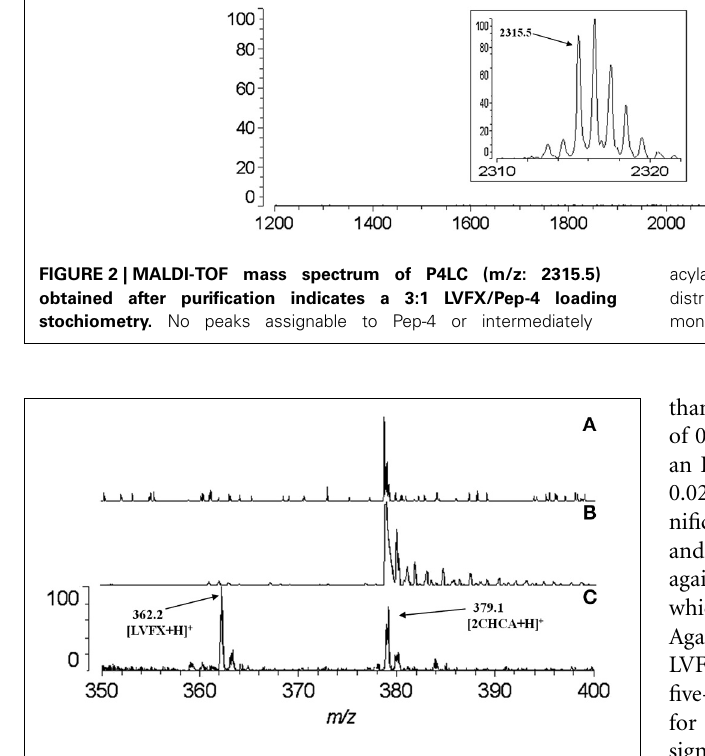
FIGURE 3 | Comparison of spectra at the region where LVFX m/z should appear. The absence of any discernible peak near 362.2 in the spectrum for P4LC (A) indicates that no LVFX contamination was present in isolated conjugate product. Spectra for matrix alone (B) and LVFX alone (C) are shown for comparison. As evidenced in the spectra, matrix-related peaks did not interfere with detection of the peak assigned to LVFX.